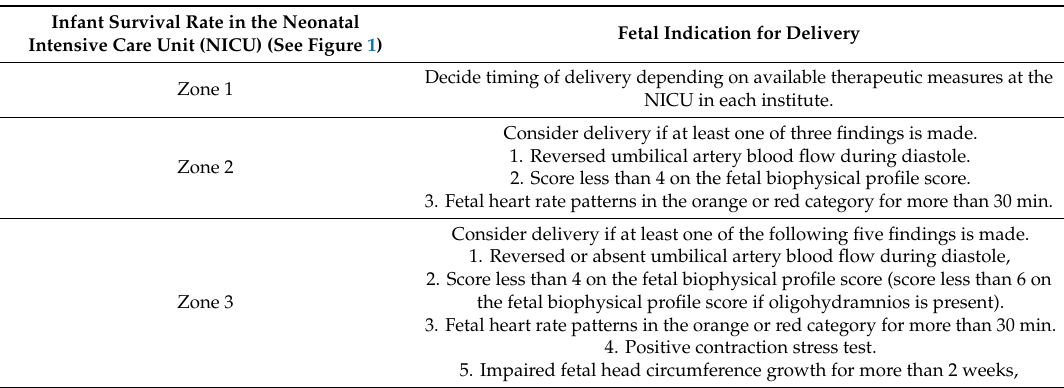
Figure 1. Infant survival rate in the neonatal intensive care unit (NICU) categorized according to birth weight and gestational week at birth (%). This figure was established on the basis of the results from the multicenter survey of very low birthweight infants in Japan using a network database. The survey data included infant survival rates in the NICU categorized by birth weight and gestational week at birth. The infant survival rate data acquired from the survey were preprocessed with the moving average method and divided into three groups. The first group was defined as Zone 1, where the infant survival rate in the NICU was less than 60% (pink background). The second group was defined as Zone 2, where the infant survival rate in the NICU ranged from 60% to 95% (yellow background). The third group was defined as Zone 3, where the infant survival rate in the NICU was 95% or higher (blue background). Table 1. The fetal indications for delivery in the tadalafil for fetuses with early-onset growth restriction (TADAFER) phase II study.